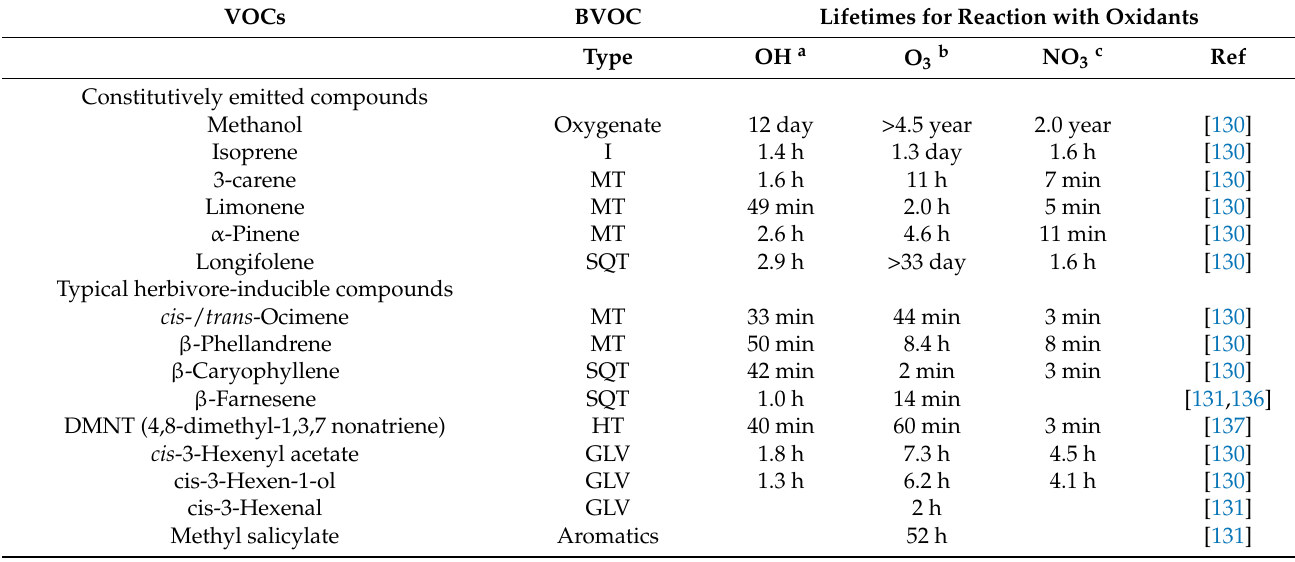
Table 4. Examples of calculated atmospheric lifetimes of some constitutively emitted and herbivore-induced BVOCs in reactions with major reactive atmospheric oxidants. BVOC classes: I = isoprene, MT = monoterpene, SQT = sesquiterpene, HT = homoterpene, GLV = C6 green leaf volatile. Major oxidants: OH = hydroxyl radical, O 3 = ozone, NO 3 = nitrate radical.